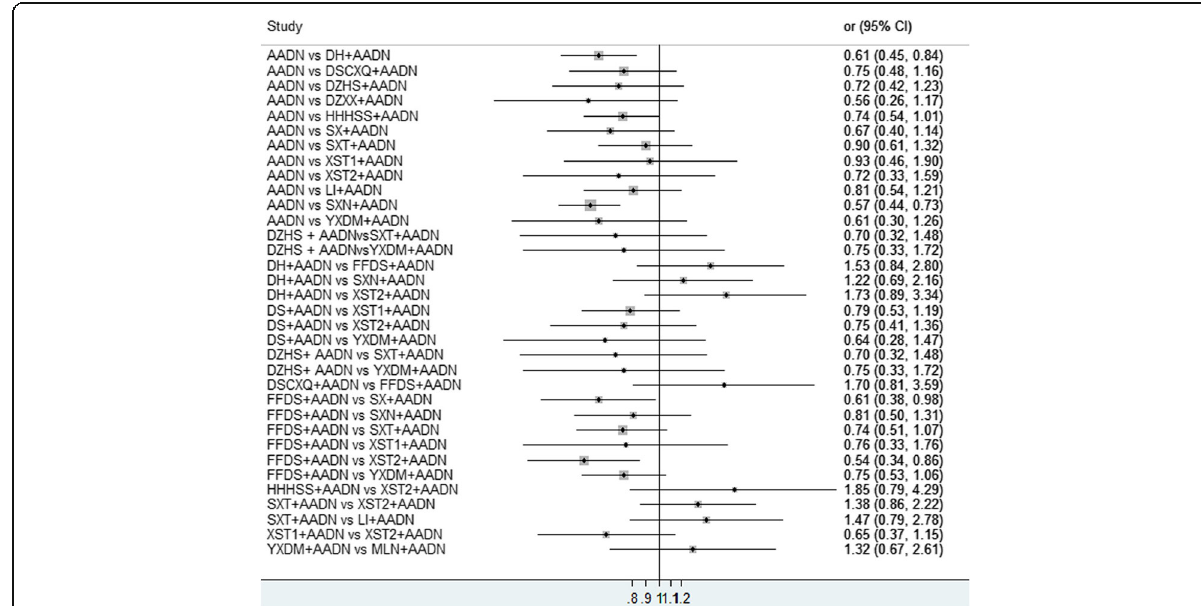
Fig. 3 Forest graph of Meta-analysis on the markedly effective